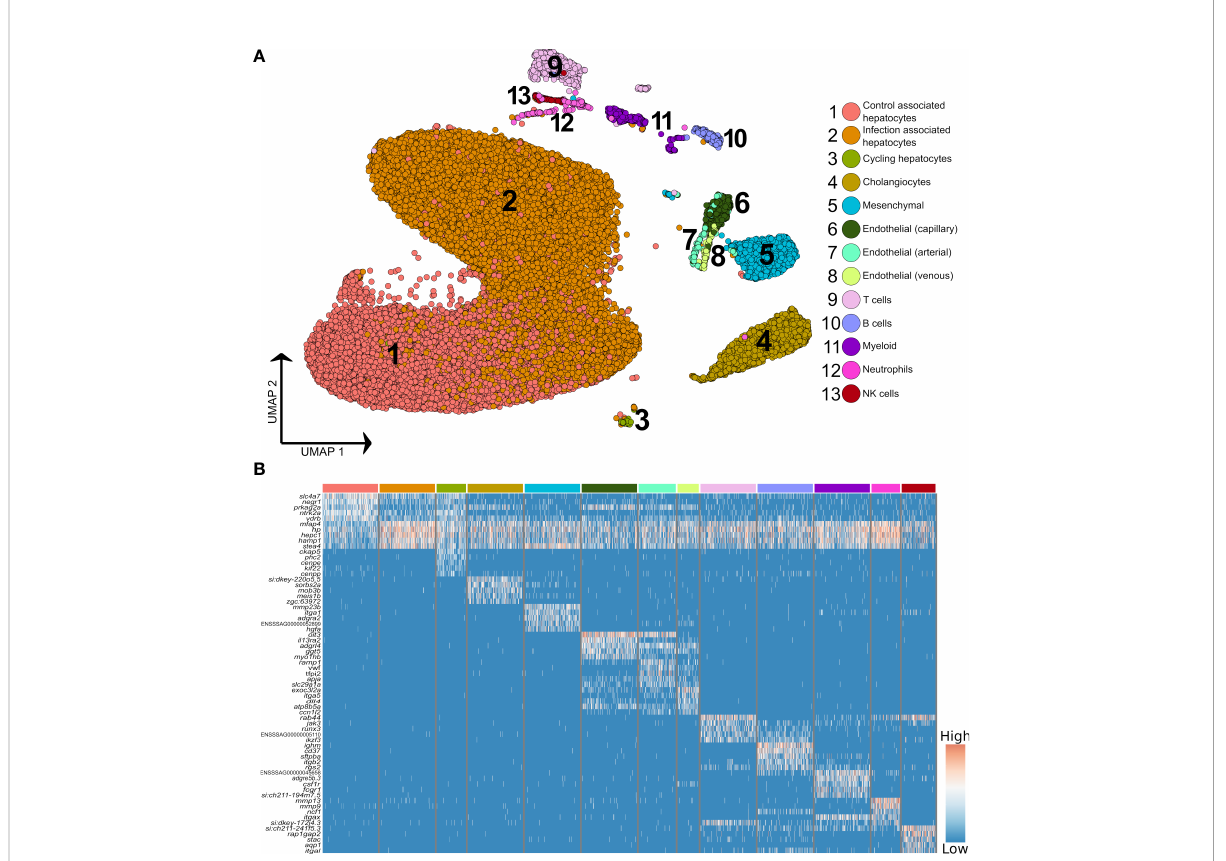
FIGURE 2 Higher resolution atlas of Atlantic salmon liver cells de fi ned by snRNA-Seq. (A) Unbiased graph-based clustering reveals varying heterogeneity levels across the major liver cell types, presented on a UMAP. Each cell population retains the gene signature of the parent lineage (Supplementary Figure 2), while also displaying its own distinct transcriptomic pro fi le, presented here as a heatmap (B) , inclusive of the top 10 marker genes based on differential gene expression against all other cell clusters. The colour bars above columns on the heatmap illustrate the cell types to which the genes shown were identi fi ed as markers (matched to part A